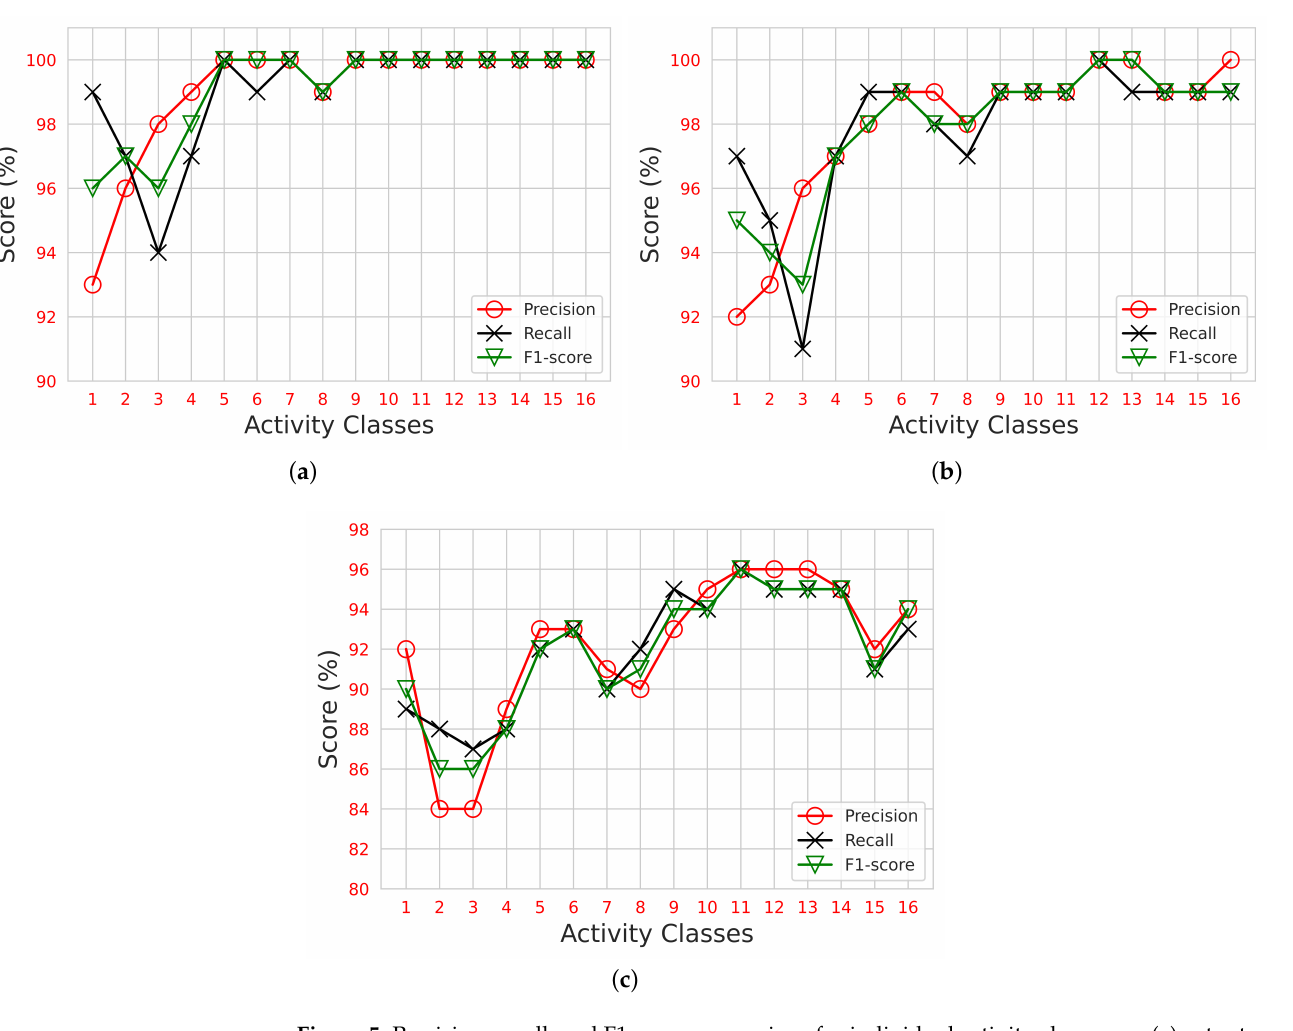
Figure 5. Precision, recall, and F1-score comparison for individual activity classes on: ( a ) extra tree; ( b ) random forest; ( c ) decision tree.